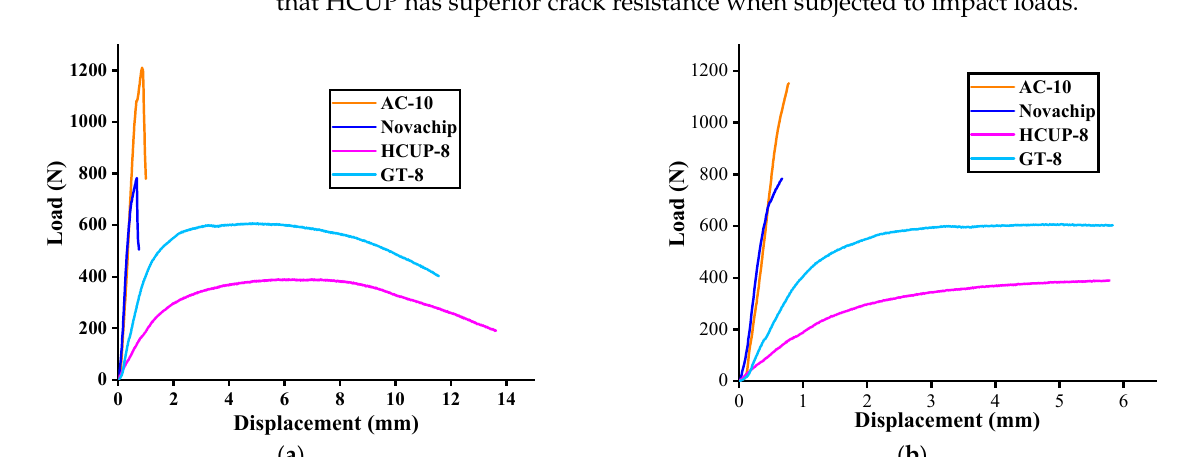
Figure 7. Load–displacement curve of impact toughness test: ( a ) load–displacement curve; ( b ) calculation diagram of im-